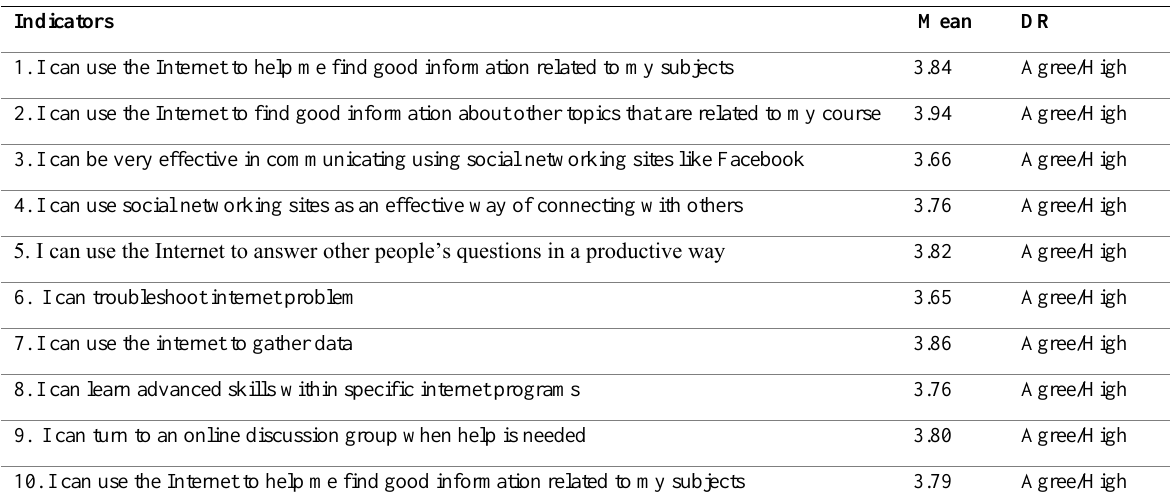
Table 2: Internet self-efficacy of the employees of Divine Word College of